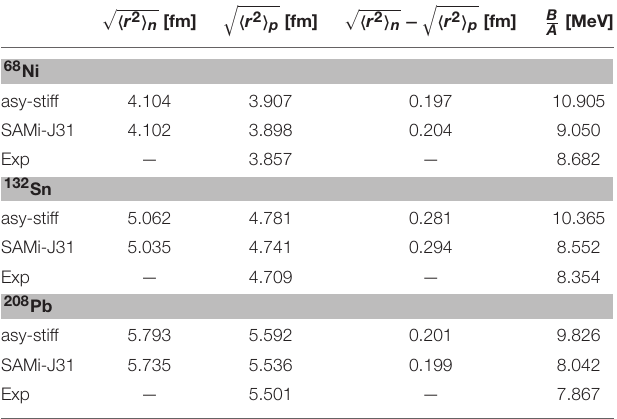
TABLE 2 | Neutron and proton root mean square radii, their difference, and binding energy for the three systems considered in our study, as obtained with asy-stiff (MI) and SAMi-J31 (MD)